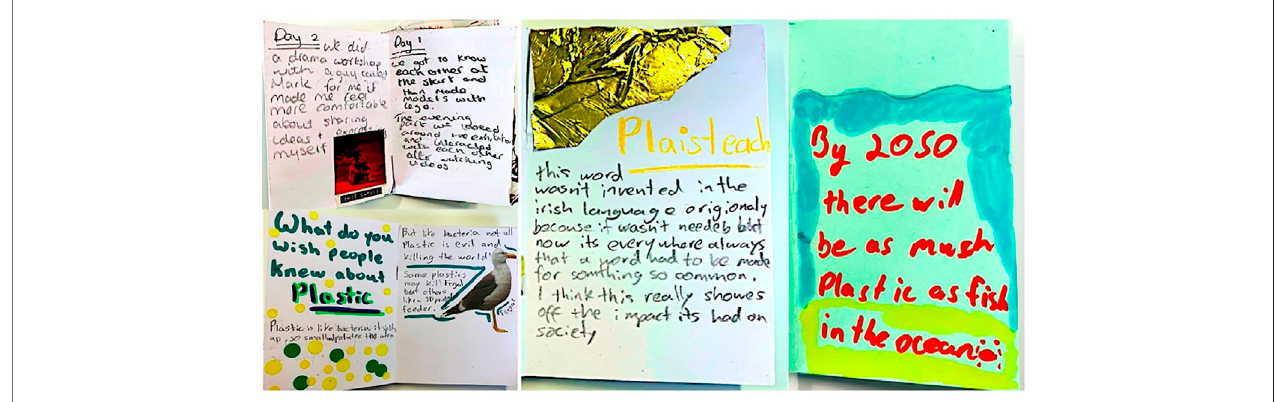
FIGURE 4 | A sample of zine pages created during STEAM workshops at Science Gallery